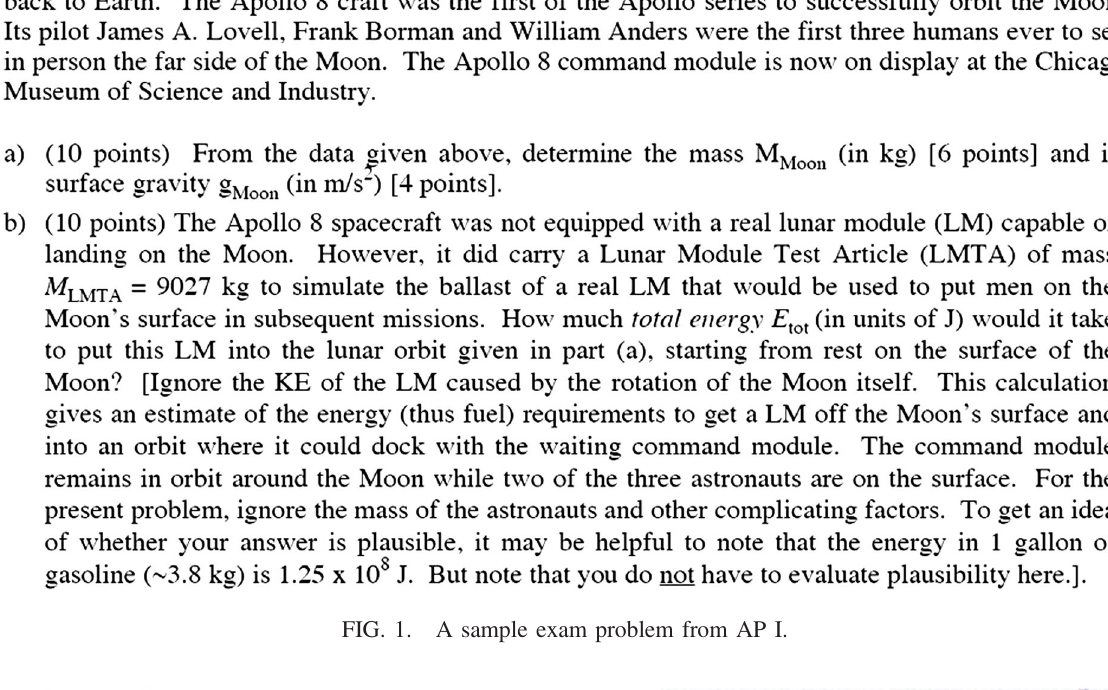
FIG. 1. A sample exam problem from AP I.